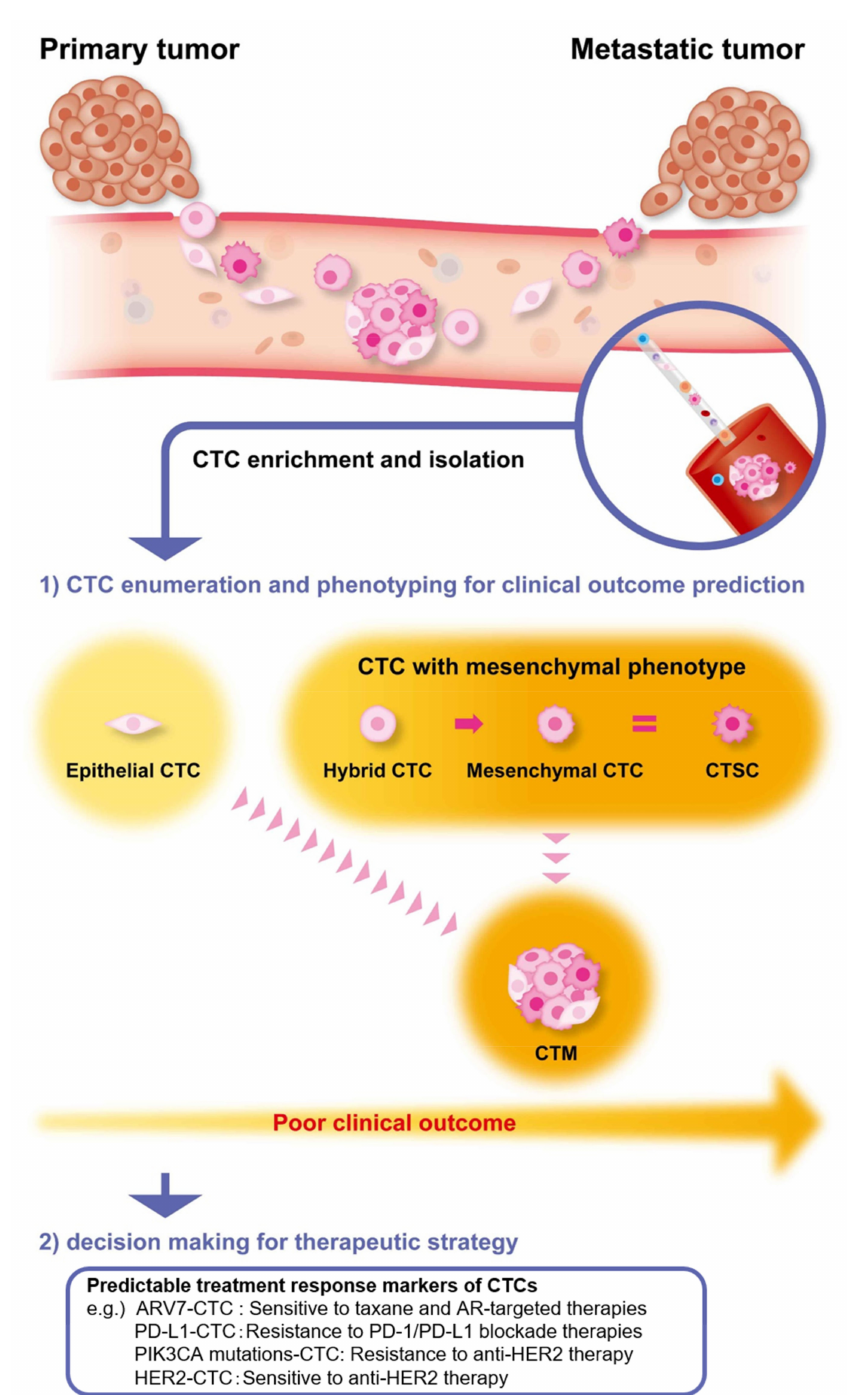
Figure 1. Schematic representation of circulating tumor cells (CTCs) during the metastatic process and characterization as a clinical biomarker after isolation. During the metastatic process, CTCs undergo gradual or full epithelial-to-mesenchymal transition (EMT) by which the primary epithelial tumor cells acquire mesenchymal characteristics and enhance metastatic and invasive abilities. Circulating tumor stem cells (CTSCs) exhibit the stem cell properties and the mesenchymal phenotype. Circulating tumor microemboli (CTM) are the CTC clusters, which often appear to be a heterogeneous cell population. The presence of CTCs and CTM with mesenchymal markers associate with chemoresistance and poor clinical outcomes, and the detection of these cells has significance as surrogate biomarkers for decision-making in therapeutic